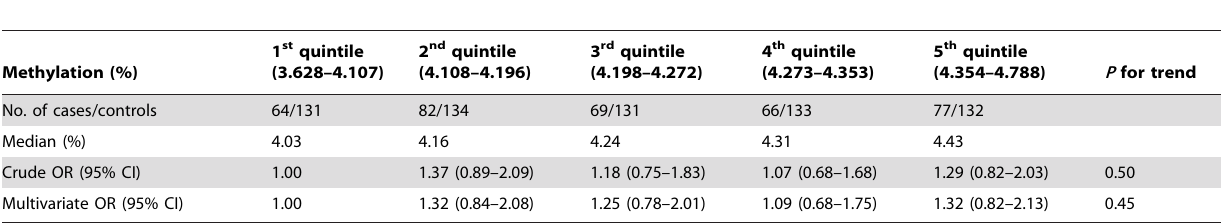
Table 3. Association between leukocyte genomic DNA methylation level and colorectal cancer risk in the nested case-control